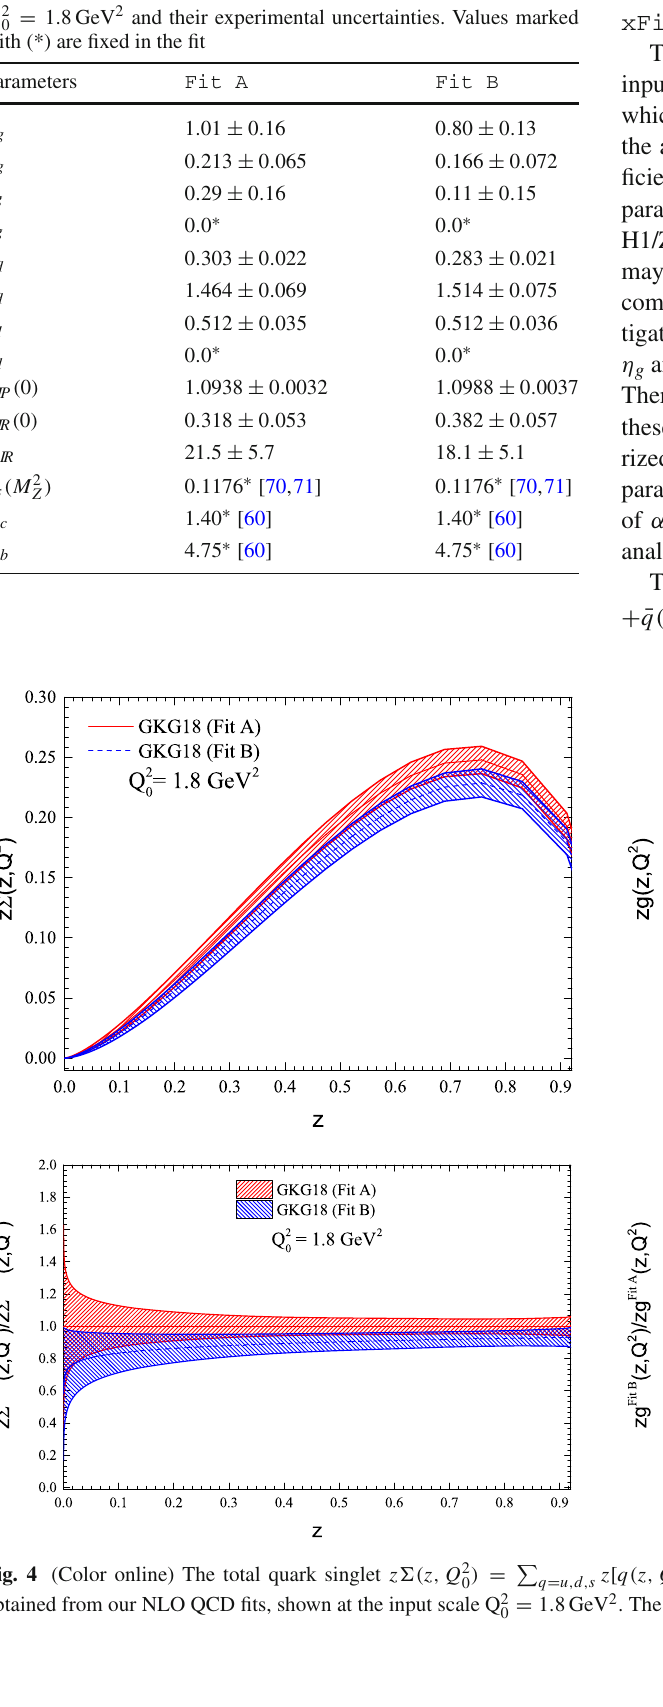
Fig. 4 (Color online) The total quark singlet z (cid:12)( z , Q 2 obtained from our NLO QCD fits, shown at the input scale Q 2